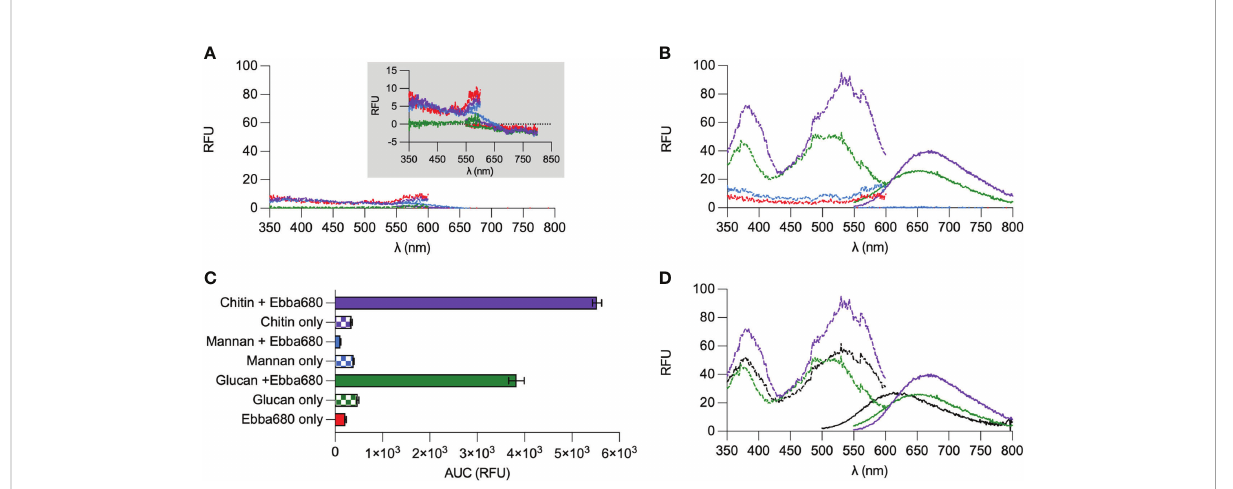
FIGURE 3 Optotracing of pure commercially available cell wall components. (A) Spec-plot of Ebba680 in free form (red), chitin (purple), mannan (blue) and b -glucans (green). A zoom-in of the spectra by reducing the range of the Y-axis is shown in the inner panel. (B) Spec-plot of Ebba680 in free form (red, as fi rst shown in (A) and Ebba680 when mixed with chitin (purple), mannan (blue) and b -glucans (green). (C) The total fl uorescence intensity, calculated as the area under the curve in the emission spectra (AUC) of Ebba680 in mixed with chitin (purple), mannan (blue), b - glucans (green), as well as the free form (red), is shown in a bar chart. (D) Spec-plot of Ebba680 when mixed with a heterogenous mixture with equal amounts of mannan, chitin, and b -glucans. Spectra of Ebba680 mixed with chitin and b -glucans (green) and as fi rst shown in (B) is included for comparison. All lines and bars show mean of n=3, with three technical repeats. In (C) , the standard deviation is shown. Dashed lines in spec-plots indicate the excitation spectra (dash), while solid lines indicate the emission